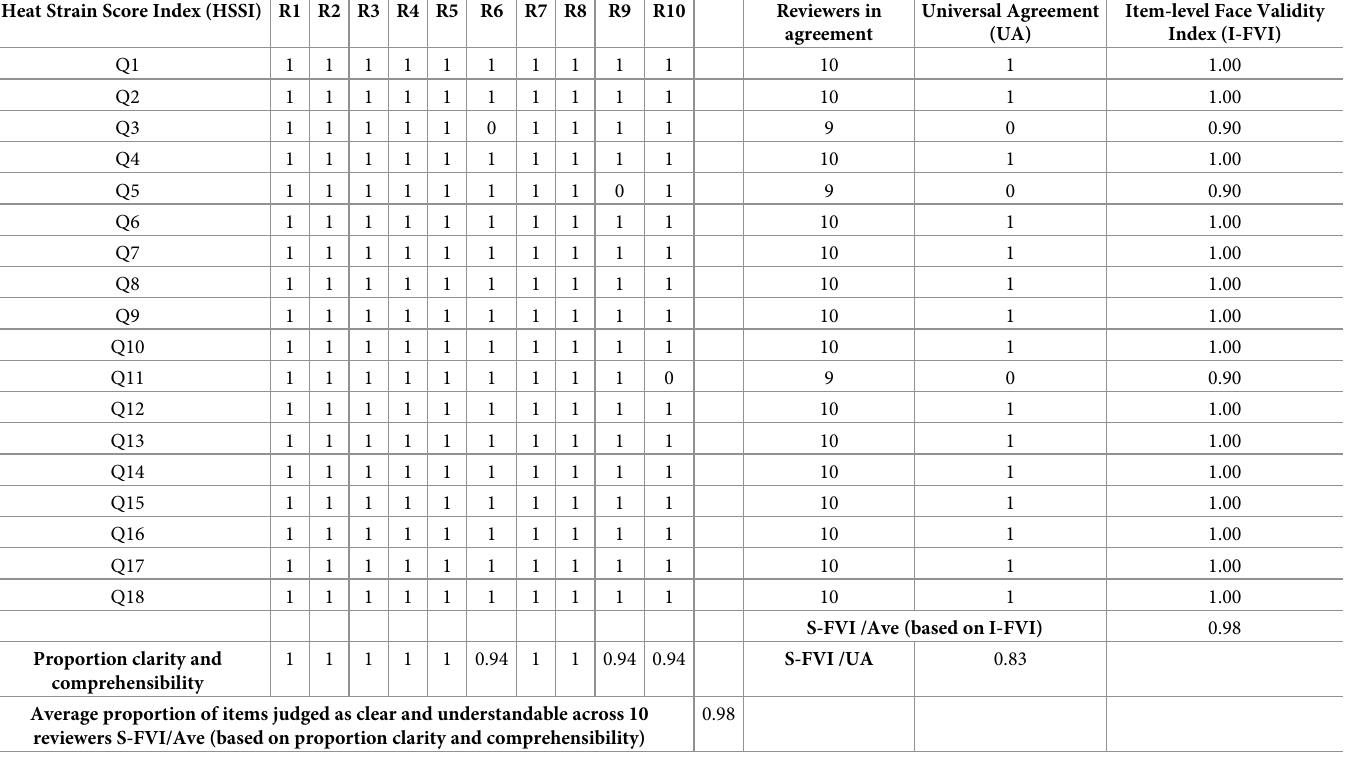
Table 3. The clarity and comprehensibility ratings on item scale by the 10 reviewers and the calculation of different FVI indices for the translated Malay version of